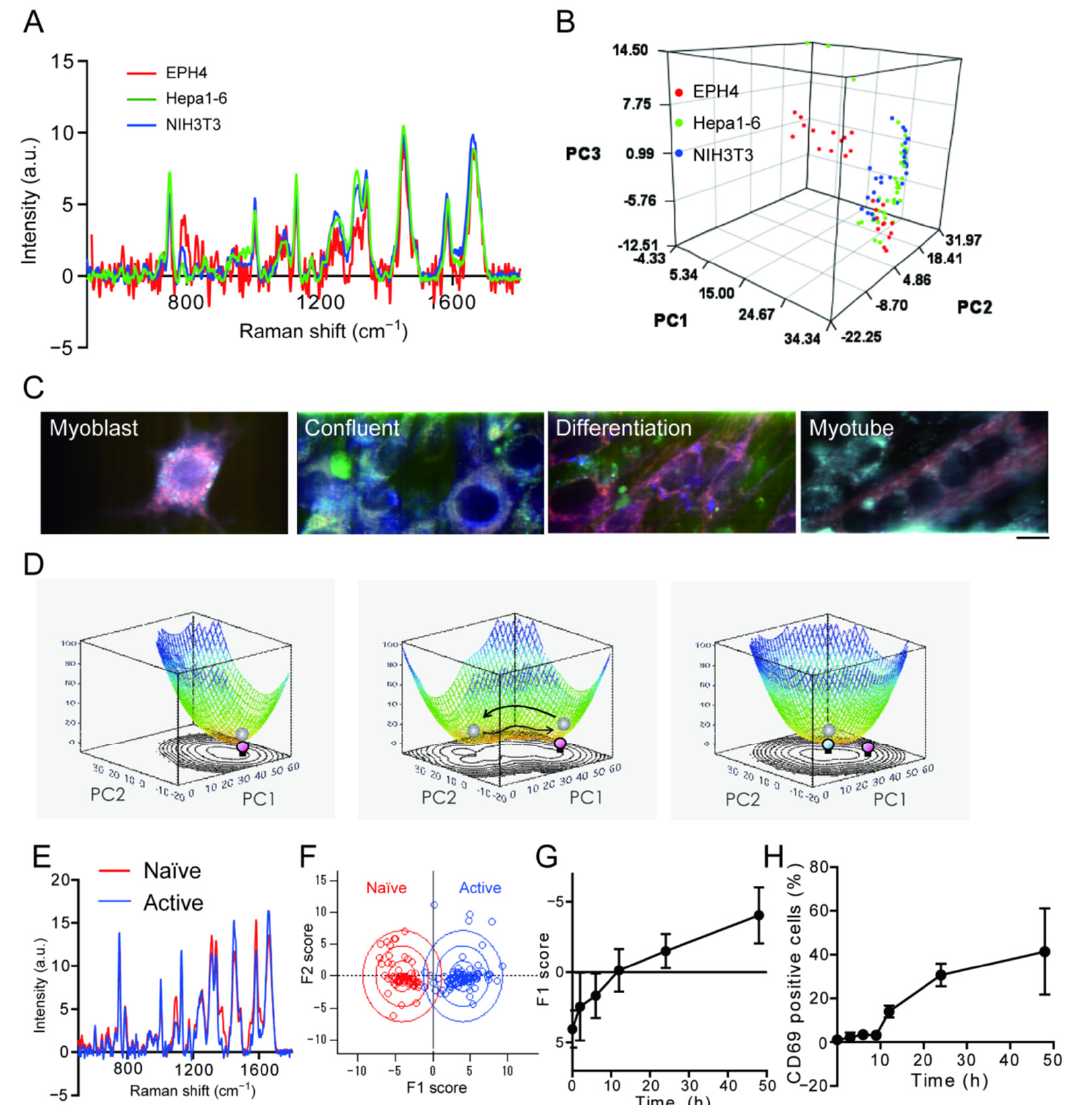
Figure 2. Detection of cell-state change during differentiation using Raman spectra. ( A ) Averaged Raman spectra of EPH4 cells (red), Hepa1-6 cells (green) and NIH3T3 cells (blue). ( B ) Principal component analysis score plot of Raman spectra analysis of 3 cell-lines. ( C ) Raman image of C2C12 cells during differentiation. Scale bar, 10 µ m. ( D ) Change in the potential landscapes during C2C12 differentiation estimated by the inverse of logarithm of cell population. The counter plots corresponding to the potential landscapes are also shown. ( E ) Averaged Raman spectra of naïve (red) and active (blue) T cells. ( F ) Results of discriminant analysis of the PCA scores. ( G ) Time course change of F1 score during T cell activation. ( H ) Activation time course of T cell activation assessed by CD69. Reproduction from reference